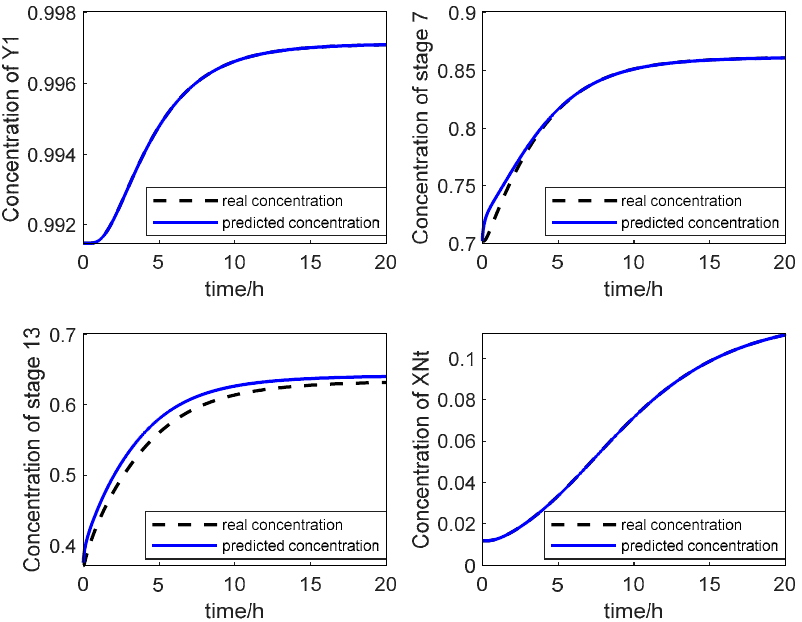
Figure 10. Dynamic tracking of product concentration at the 1st, 7th, 13th and 20th trays when Z f +10%.